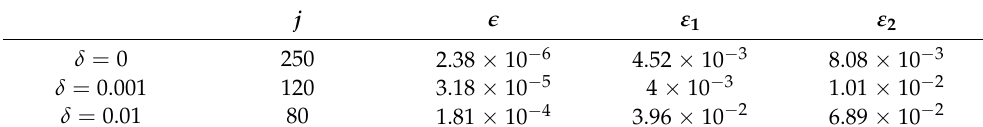
Table 2. The values of j , (cid:101) , ε 1 and ε 2 with various noise levels δ for Example 2.